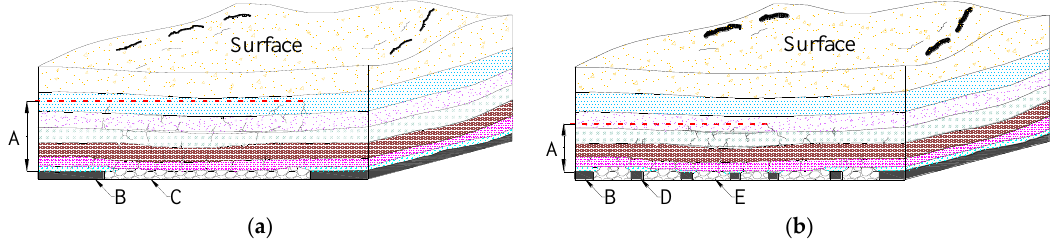
Figure 3. Characteristics of the overlying strata in the stope: ( a ) the movement characteristics of the overlying strata by the traditional longwall caving method; and ( b ) the movement characteristics of the overlying strata by the SBM method. A—the height of the water-flowing fissure zone (HWFZ); B—Coal seam; C—Longwall mining working face; D—Protection coal pillar; E—SBM working face.